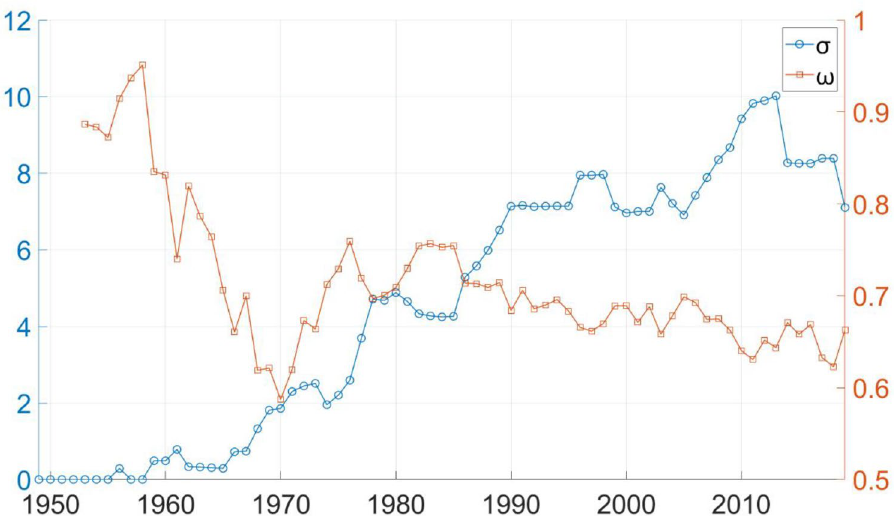
Figure 4. Long-term evolution of different small-world metrics. σ makes comparisons only to random networks, while ω includes regular networks as well.